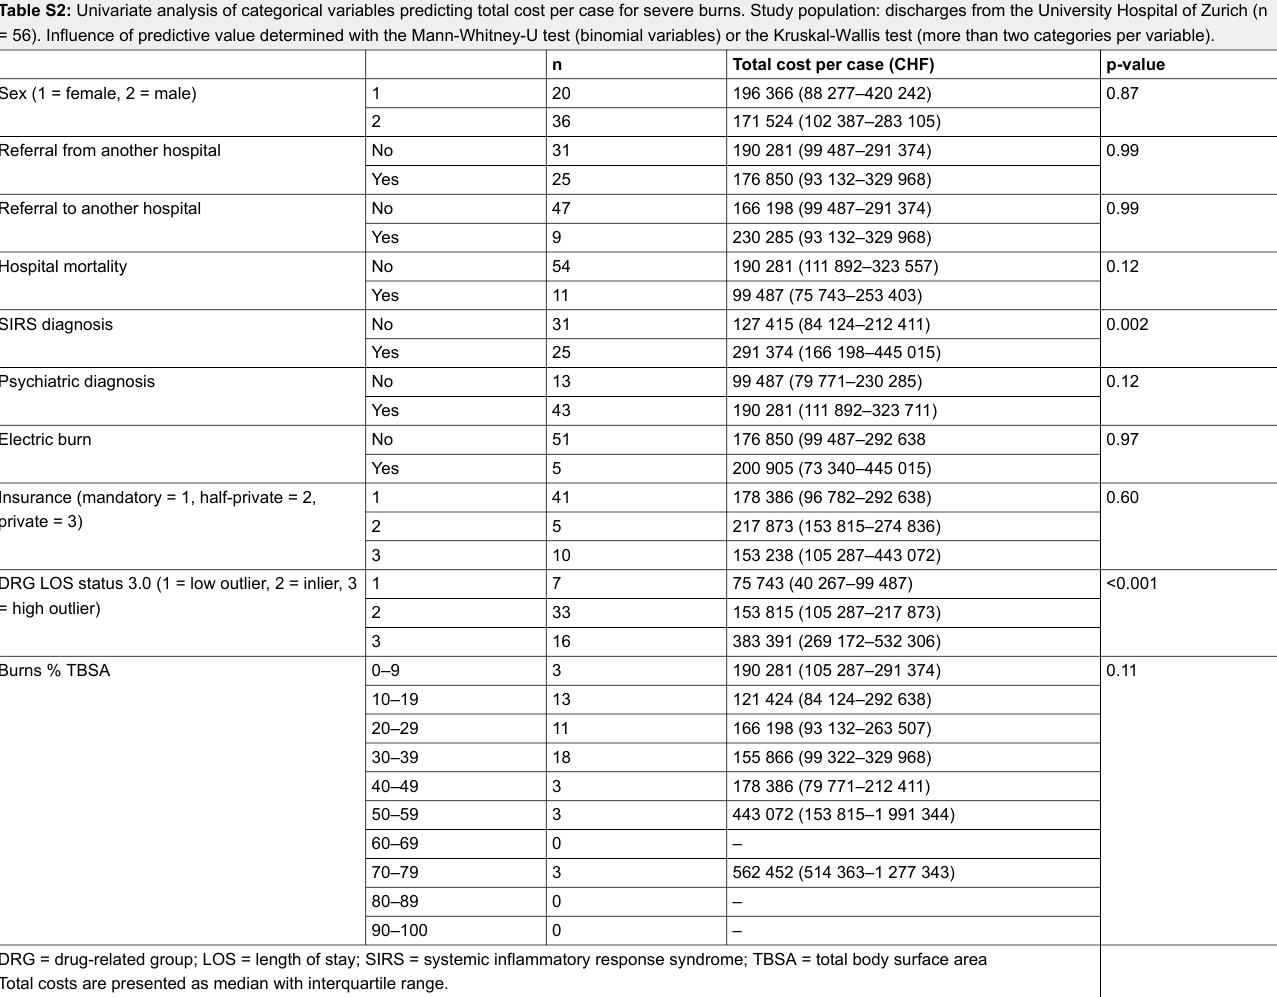
Table S2: Univariate analysis of categorical variables predicting total cost per case for severe burns. Study population: discharges from the University Hospital of Zurich (n = 56). Influence of predictive value determined with the Mann-Whitney-U test (binomial variables) or the Kruskal-Wallis test (more than two categories per variable). n